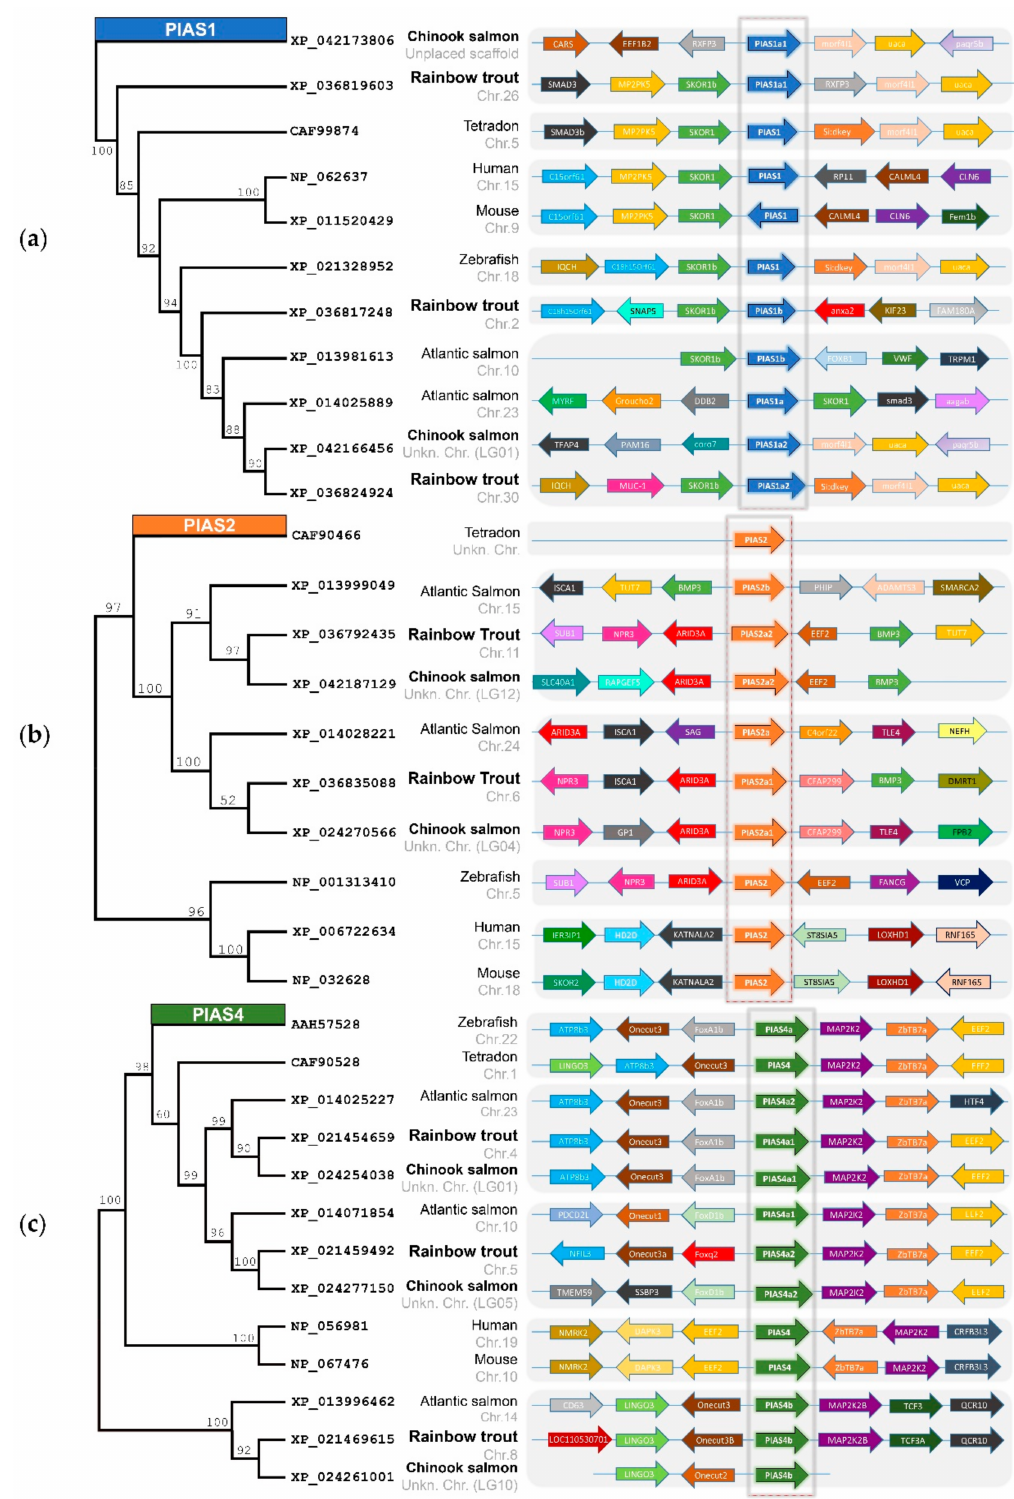
Figure 2. Phylogenetic relationship and synteny between the ( a ) PIAS1 , ( b ) PIAS2 , and ( c ) PIAS4 genes from different vertebrate species. The bootstrap values of the phylogenetic analysis are given at the nodes of the tree. The NCBI protein accession codes, species names, and chromosomal location are listed between the phylogenetic and synteny analyses; the target species are labelled in bold. Arrows represent the reading direction of genes found in synteny; the same colours indicate orthologous genes. The figure is not